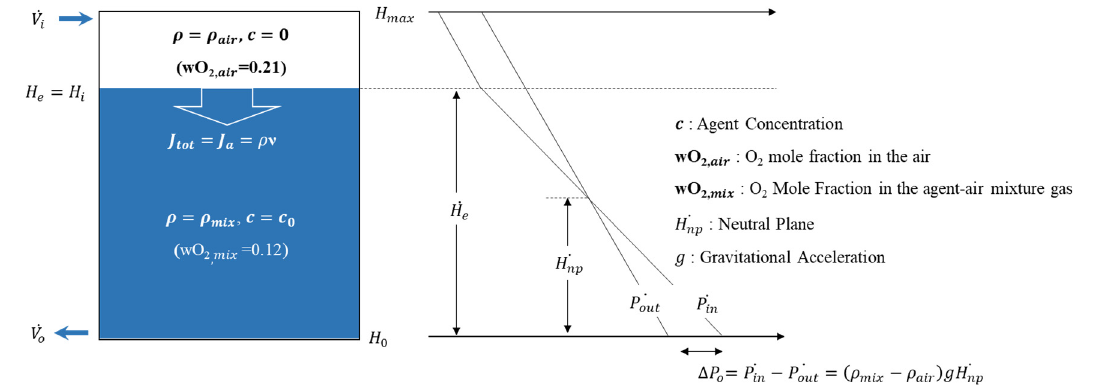
Figure 2. Schematic diagram of the O 2 concentration distribution of the sharp descending interface model.